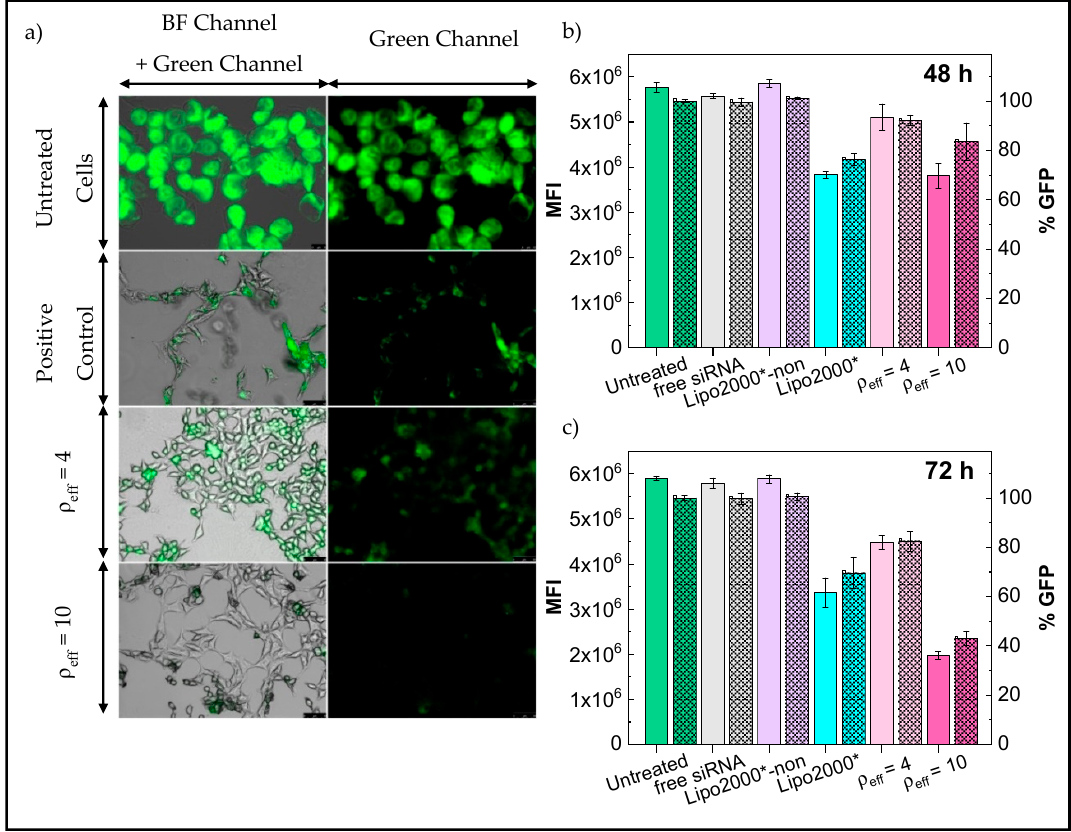
Figure 4. ( a ) Epifluorescence microscopy images: Merged images (bright field (BF) + green fluorescence channel (left)) and green fluorescence channel (right) for HeLa-GFP cells treated with C 3 (C 16 His) 2 /MOG-siRNA lipoplexes ( α = 0.2; ρ eff = 4 and 10) and Lipo2000*-antiGFP-siRNA as positive control, after 72 h of incubation. Scale bars are 50 µm, except untreated cells which are 10 µm. GFP knockdown levels expressed as MFI (unstriped bars) and % GFP (striped bars) for HeLa-GFP cells at 48 ( b ) and 72 h ( c ) of incubation. Cells treated by the lipoplexes were collected at α = 0.2 and ρ eff = 4 (light pink bars) and 10 (dark pink bars). Untreated cells were used as a reference of the highest MFI and % GFP value. Free siRNA and Lipo2000*-non-targeting siRNA were used as negative controls (gray and purple bars, respectively) while Lipo2000*-antiGFP-siRNA was used as positive control (blue bars). All experiments were performed with 10% ( v/v ) of HS. The data represent the mean ± SD of three independent wells.